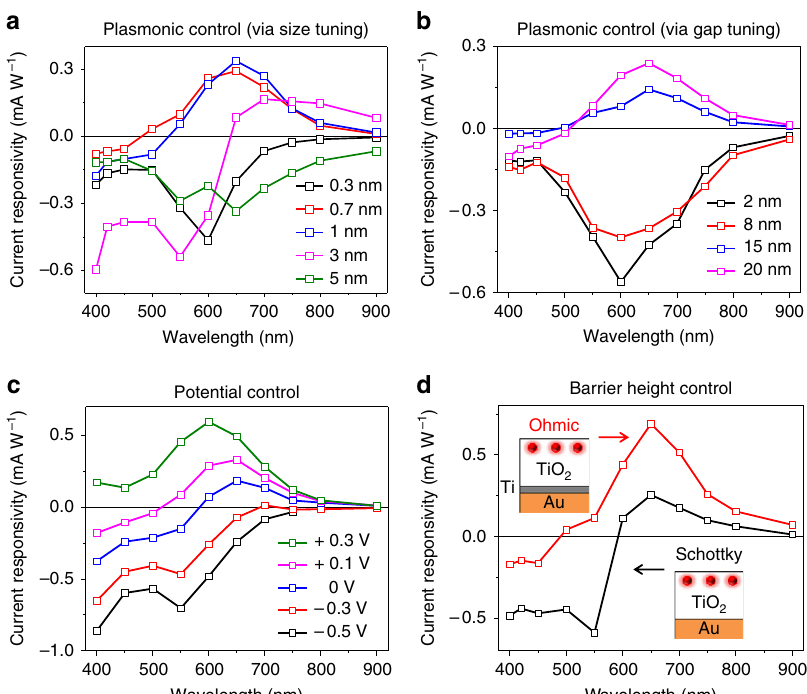
Fig. 6 Tailoring the current responsivity and polarity-switching wavelength of the dual-plasmon device. a Current responsivity of the device with AuNPs of various diameters (passive plasmonic control). The values indicate the thickness of the deposited Au fi lm before annealing it to form the AuNPs. b Current responsivity of the device with various gaps between the AuNPs and the Au fi lm, whereas the thickness of the TiO 2 layer is kept constant (passive plasmonic control). c Current responsivities of the device at various applied voltage values (active potential control). d Effect of the Ohmic contact at the Au fi lm/TiO 2 interface (passive barrier height